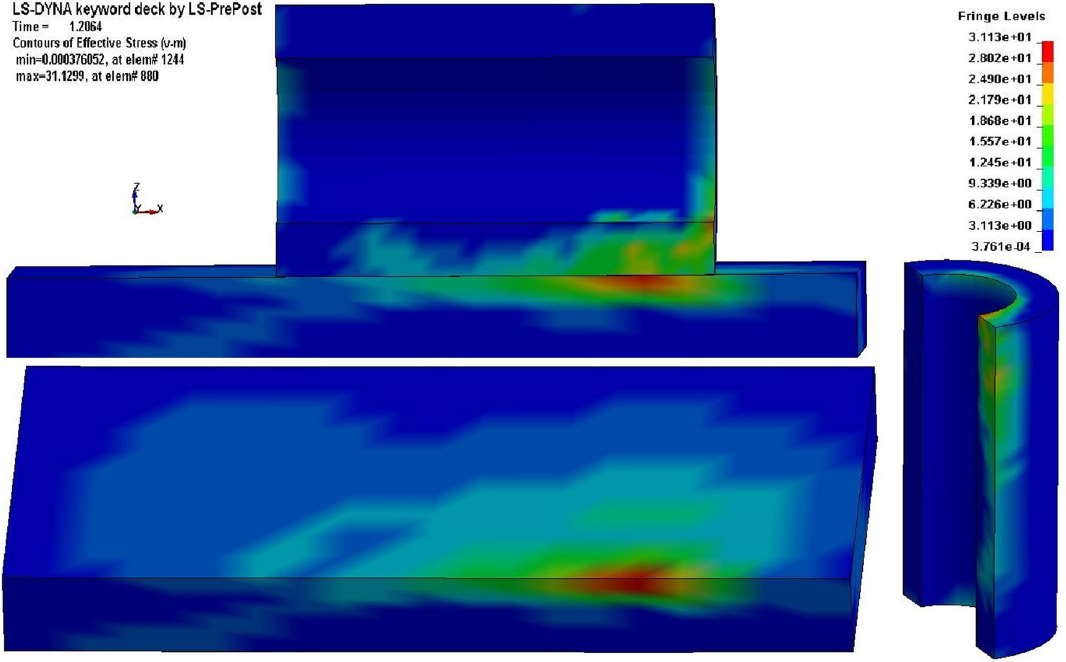
Fig. 26 Contours of von-Mises stress at the time of impact.